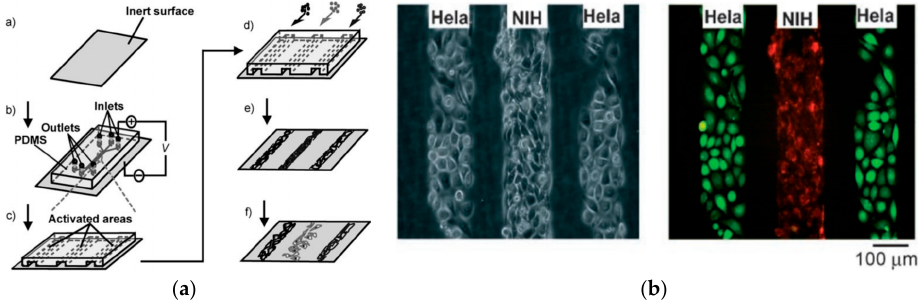
Figure 4. ( a ) Strategy for patterning cells. a) Self-assembled monolayers (SAMs) are formed on a gold- coated surface; b) stamping, followed by applying a microfluidic PDMS cover; c) application of a